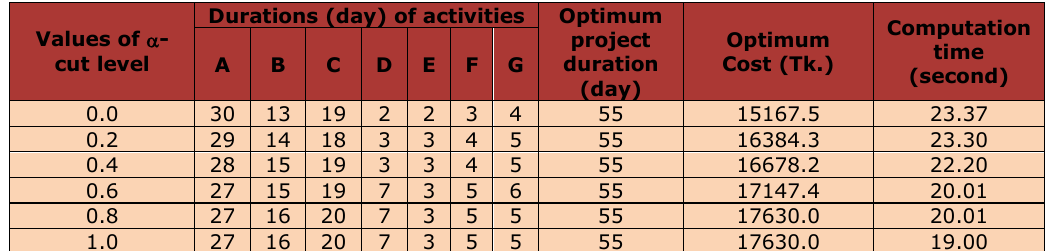
Table 3. Effect of  -cut value on the optimum solution